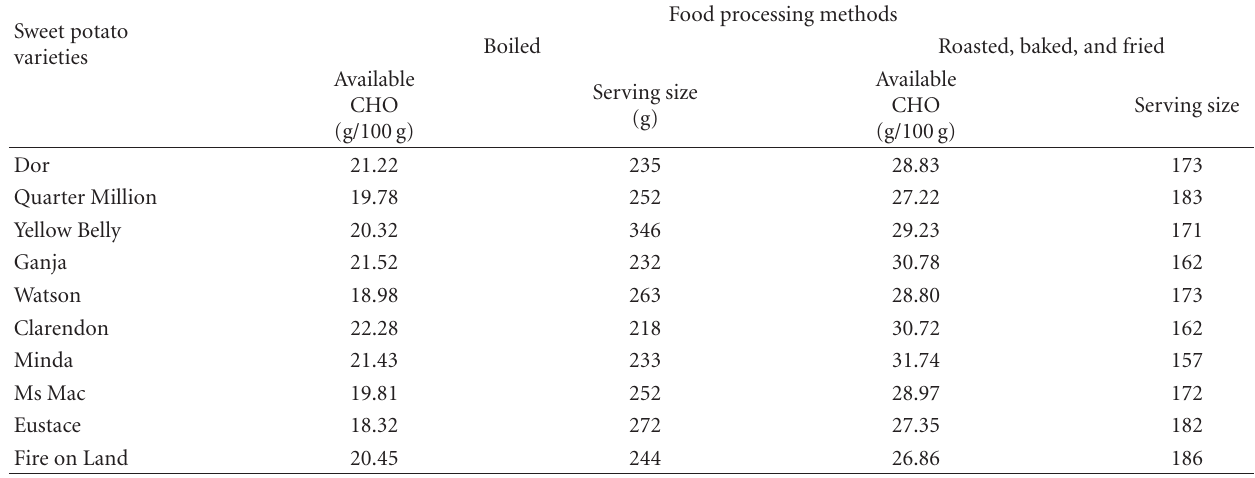
∗ Except for 100 grams of boiled sweet potatoes. § Containing 50g available